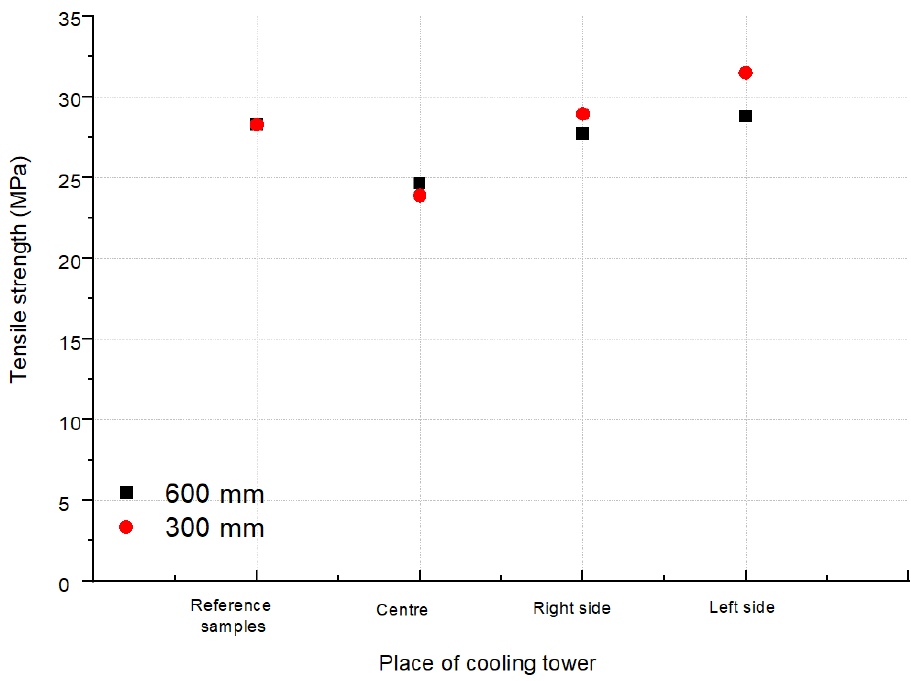
Figure 10. Tensile strength from block positions according to Figure 2 for CT2.